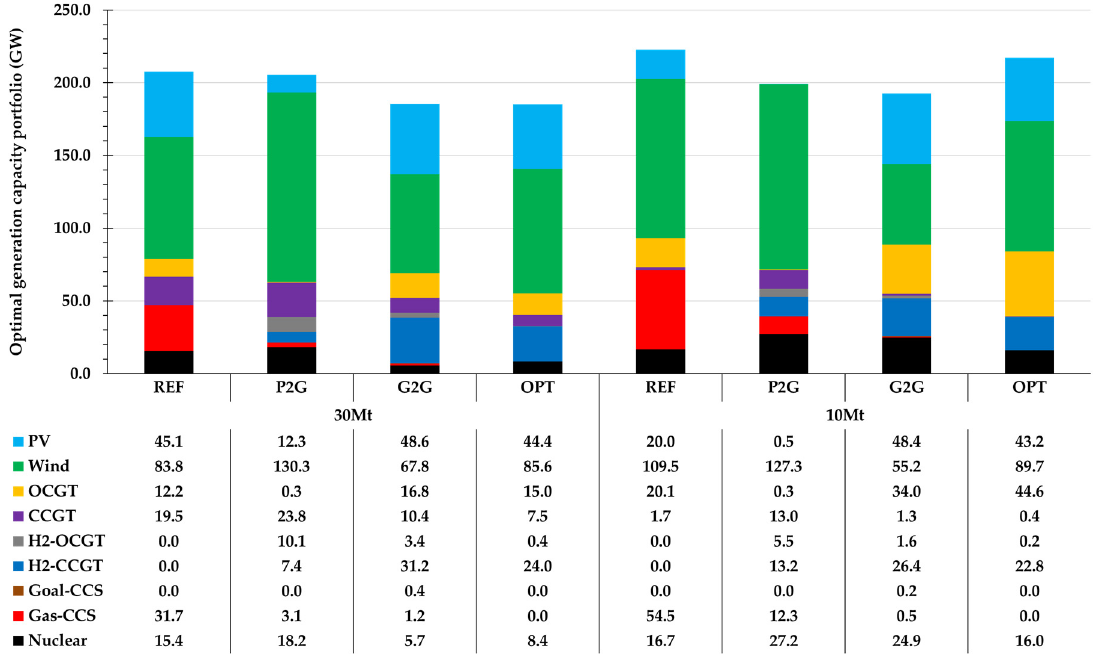
Figure 4. Optimal generation capacity portfolio in different scenarios.